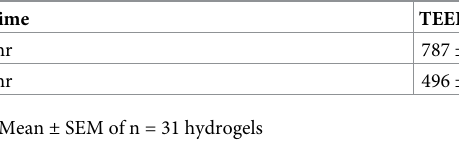
Table 3. TEER values of hydrogel BBB models during transport assays.